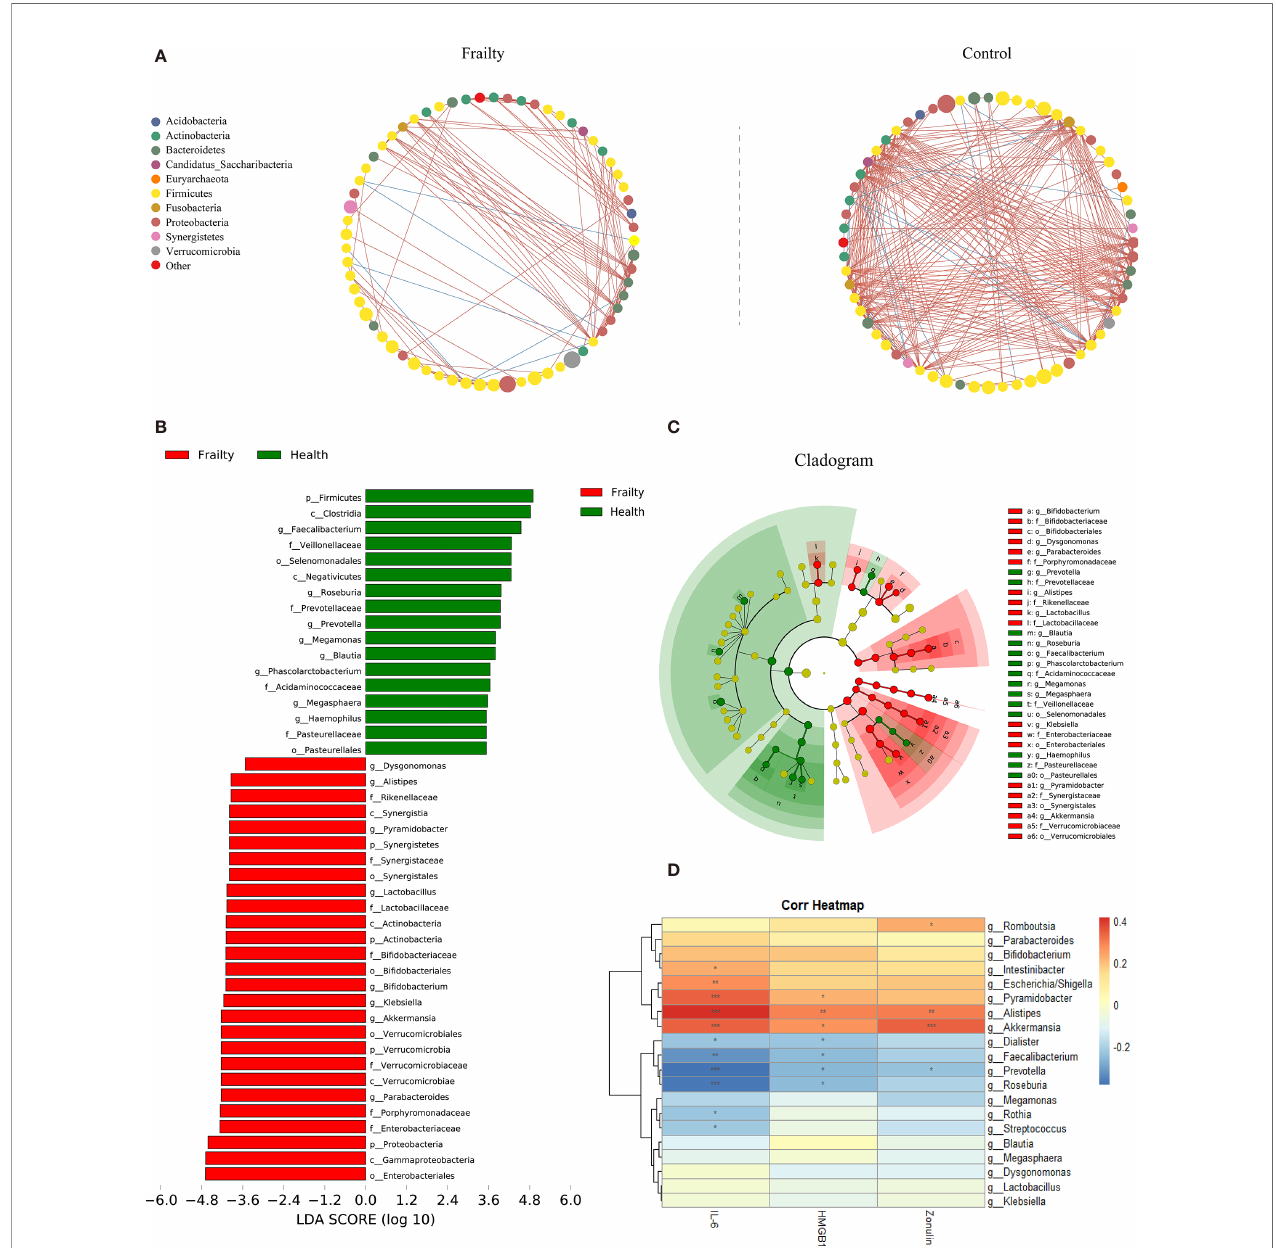
FIGURE 3 | The distinctive gut microbial co-abundance networks between frail and control group (A) . The relationships among the top 100 most abundant taxa in the frail and control groups were evaluated using Spearman ’ s correlation analysis. The size of the nodes was proportional to the relative abundance. The positive and negative correlations were represented using red and blue lines, respectively. Bacterial taxa differentially abundant exhibited by older adults with frailty and healthy controls. (B) A linear discriminant analysis [LDA; (log10) > 3.5] and (C) effect size (LEfSe) analysis revealed signi fi cant differences ( P < 0.01) in the microbiota exhibited by the frail (red, positive score) and control (green, negative score) groups. (D) Heatmaps showing correlations between the top 20 differentially abundant microbiota genera, in fl ammatory cytokines IL-6 and HMGB1, and the intestinal permeability marker zonulin-1. * P < 0.1, ** P < 0.05, *** P <